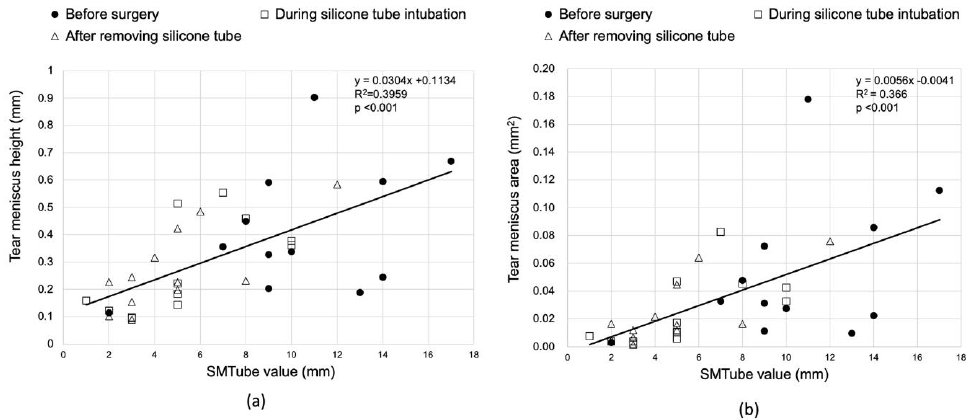
Figure 4. Correlation between the anterior segment optical coherence tomography (OCT) parameters and SMTube value. ( a ) The tear meniscus height significantly correlated with the SMTube value. ( b ) The tear meniscus area also correlated significantly with the SMTube value.